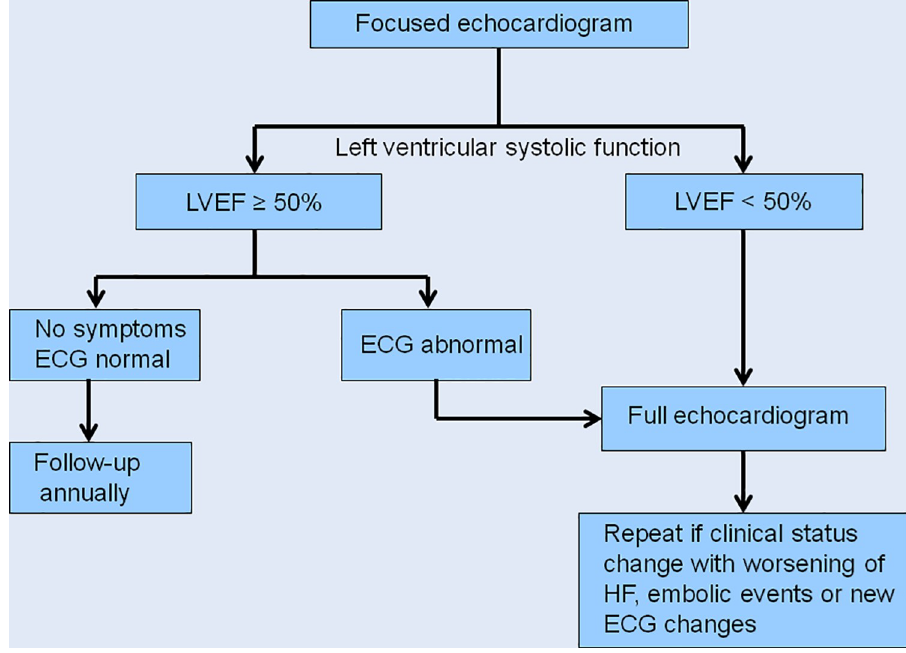
Fig 3. Management of patients with Chagas disease based on FoCUS results. A proposed approach based on left ventricular systolic function assessed by focused echocardiography.